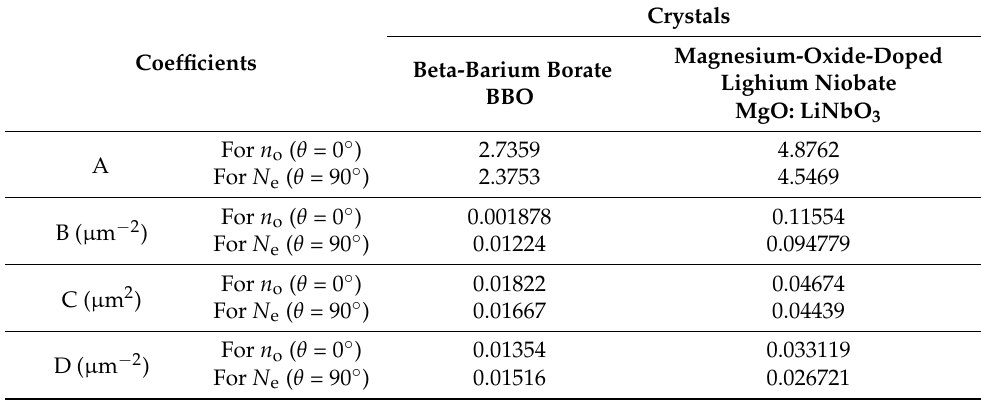
Crystals Magnesium-Oxide-Doped Beta-Barium Borate Lighium Niobate BBO MgO: LiNbO 3